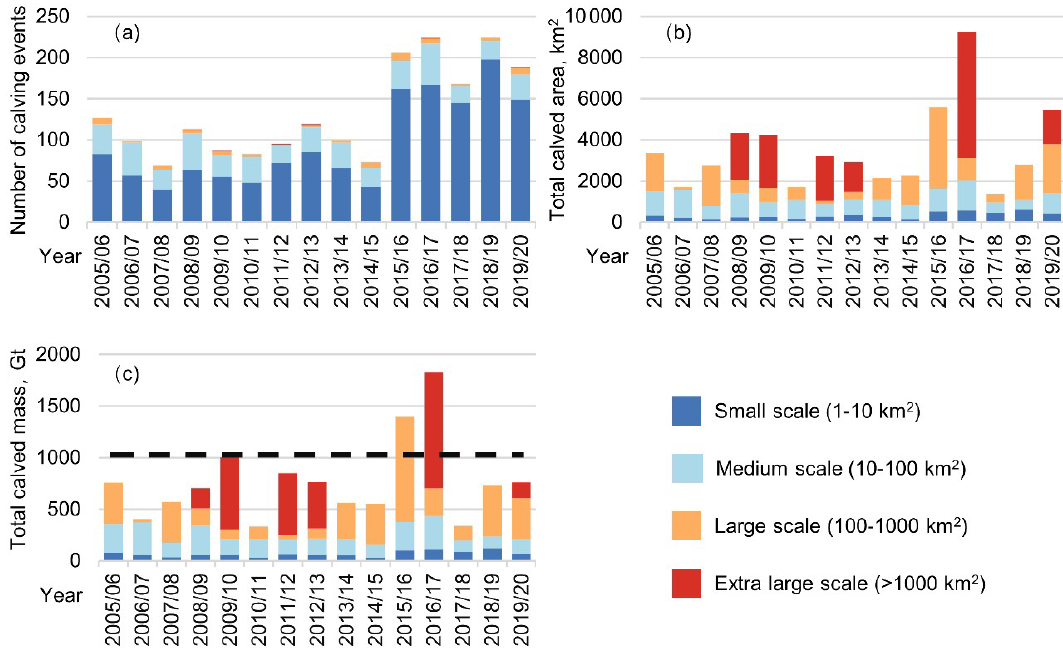
Figure 5. Temporal distribution of annual calving events at different scales of Antarctic ice shelves from August 2005 to August 2020. Panels (a–c) present the annual number of calving events, calved area, and calved mass at four scales, respectively. Horizontal dashed lines in panel (c) denote the 1026Gtyr − 1 “steady-state” calving flux of ice shelves reported by Liu et al. (2015).